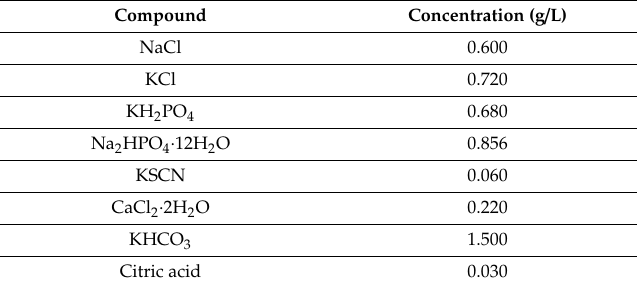
Table 1. Chemical composition of the synthetic saliva (pH =